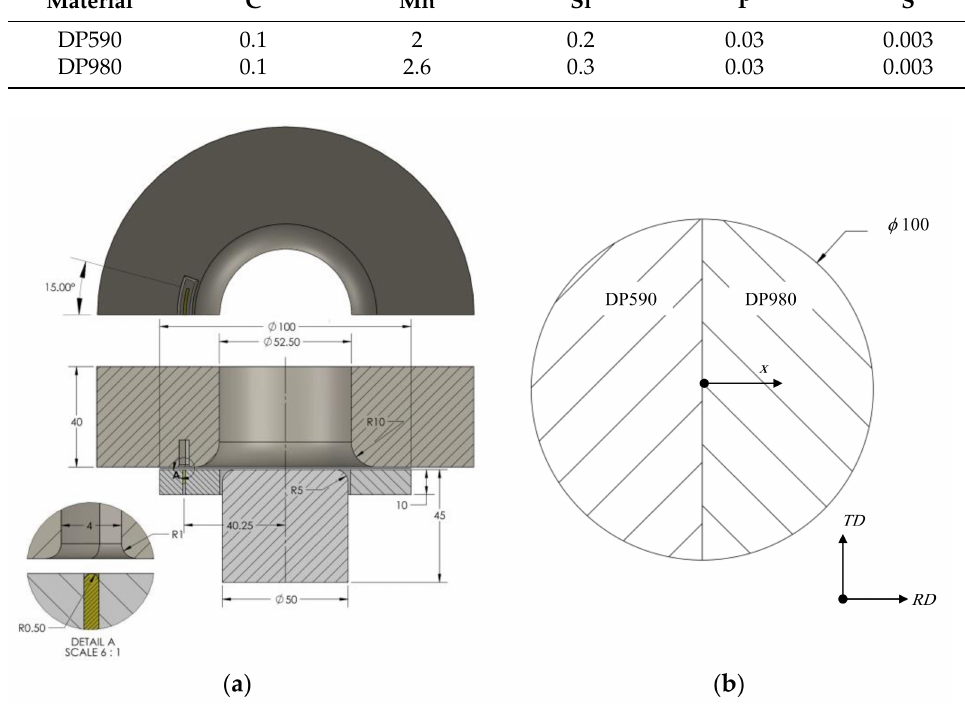
Figure 1. ( a ) Section view of cylindrical cup drawing tools, and ( b ) tailor-welded blank sheet (unit: